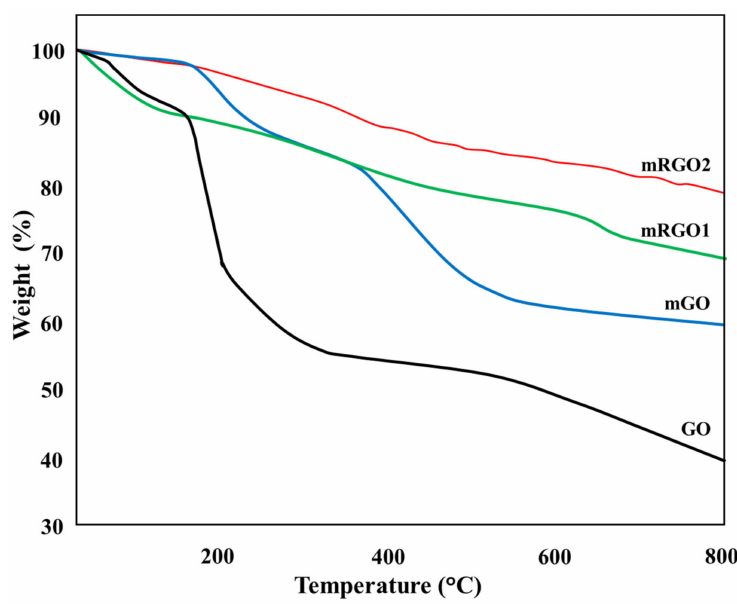
Figure 3. Thermogravimetric analyzer (TGA) thermograms of GO, mGO and mRGOs.